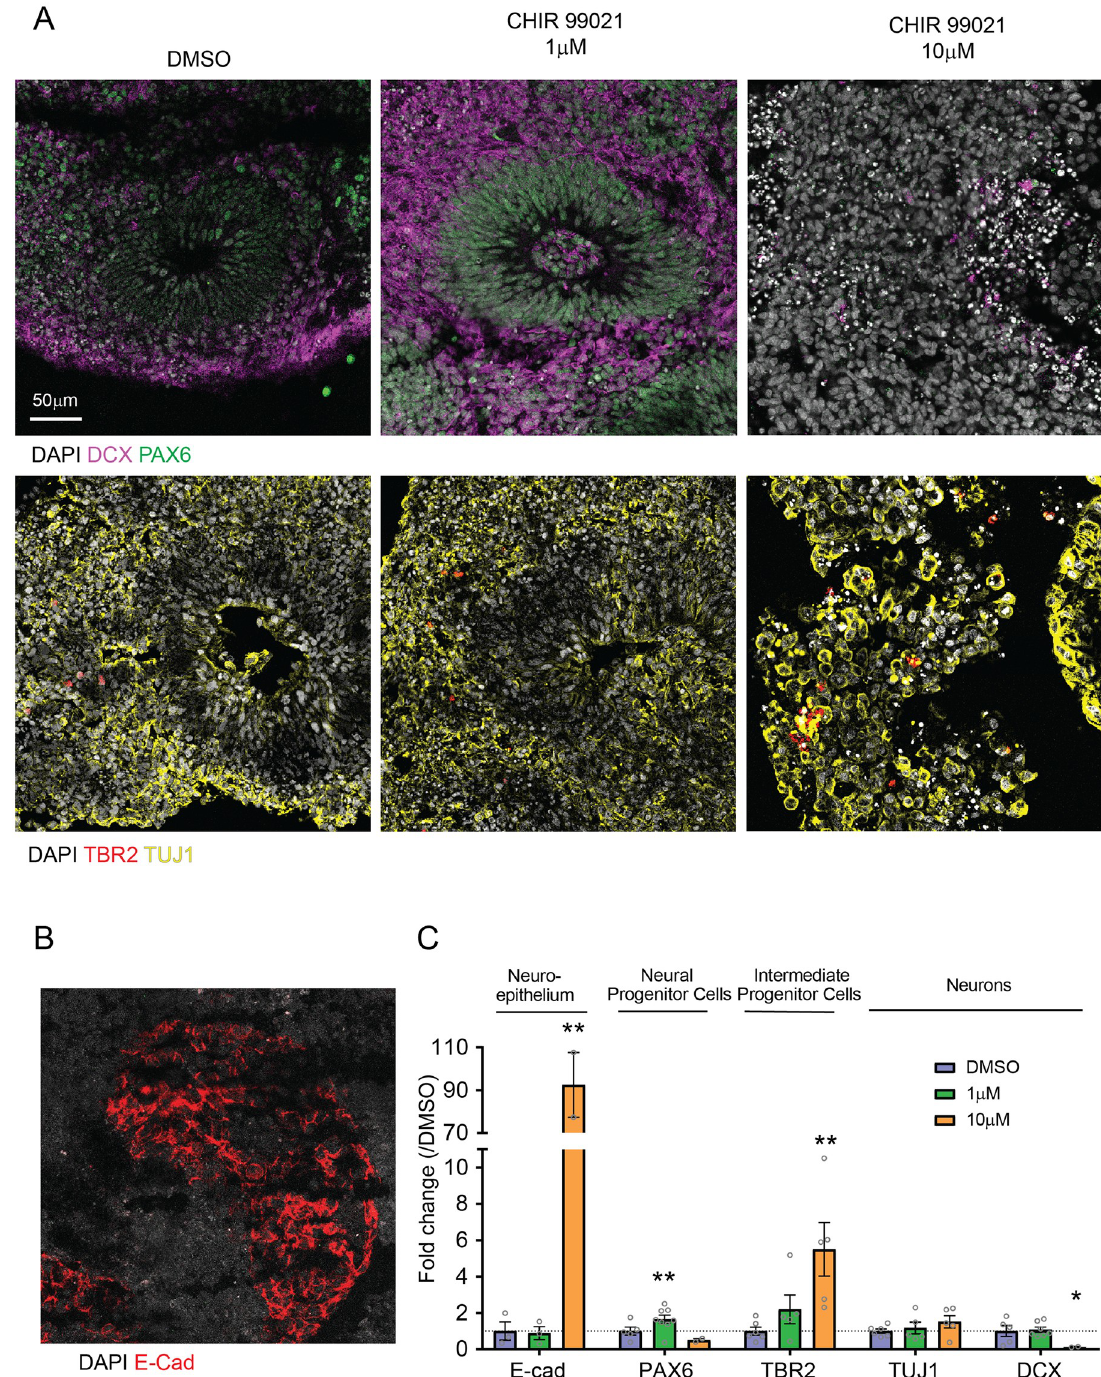
Fig 4. GSK3 β inhibition by CHIR 99021 affects neuronal differentiation of neuroepithelium in a dose dependent manner-IHC. A . Representative images of immune-stained organoids for detection of NPC marker PAX6, neuronal markers DCX and TUJ1, intermediate progenitor marker TBR2, and B . neuroepithelial marker E-cadherin. C . Quantification of the cell type marker positive areas normalized by the DAPI positive area for each organoid, and relative to DMSO organoids (E-Cad: DMSO: 1 ± 0.5046, n = 3; 1 μ M: 0.8878 ± 0.3554, n = 3; 10 μ M: 92.47 ± 11.34, n = 2; DMSO vs 1 μ M, �� : p-value = 0.8646; DMSO vs 10 μ M, �� : p-value = 0.0040. PAX6: DMSO: 1 ± 0.2189, n = 5; 1 μ m: 1.834 ± 0.1585, n = 7; 10 μ M: 0.5 ± 0.09146, n = 2; DMSO vs 1 μ M, �� : p-value = 0.0099; DMSO vs 10 μ M, p-value = 0.2339. TBR2: DMSO: 1 ± 0.2185, n = 6; 1 μ M: 2.2 ± 0.7904, n = 5; 10 μ M: 5.5 ± 1.471, n = 5; DMSO vs 1 μ M, p-value = 0.1456; DMSO vs 10 μ M, �� : p- value = 0.0087; DCX: DMSO: 1 ± 0.3027, n = 5; 1 μ M: 1.078 ± 0.1477, n = 7; 10 μ M: 0.1283 ± 0.2005, n = 2; DMSO vs 1 μ M, p-value = 0.8046;